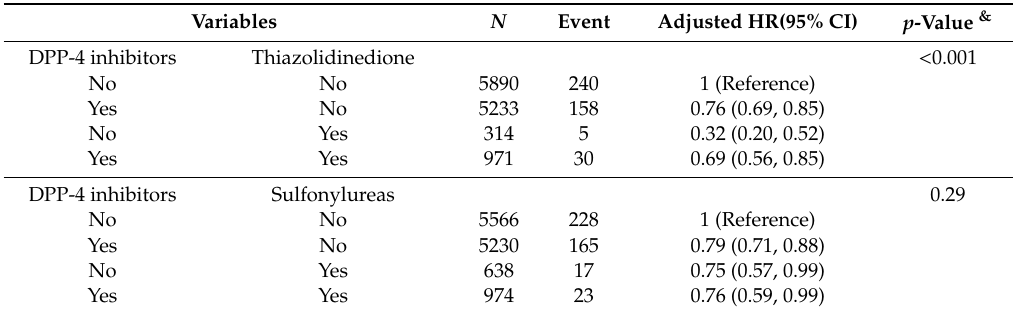
Table 4. Cox proportional hazard regression analysis for the interaction of other oral antidiabetic agents and DPP-4 inhibitors on allergic rhinitis